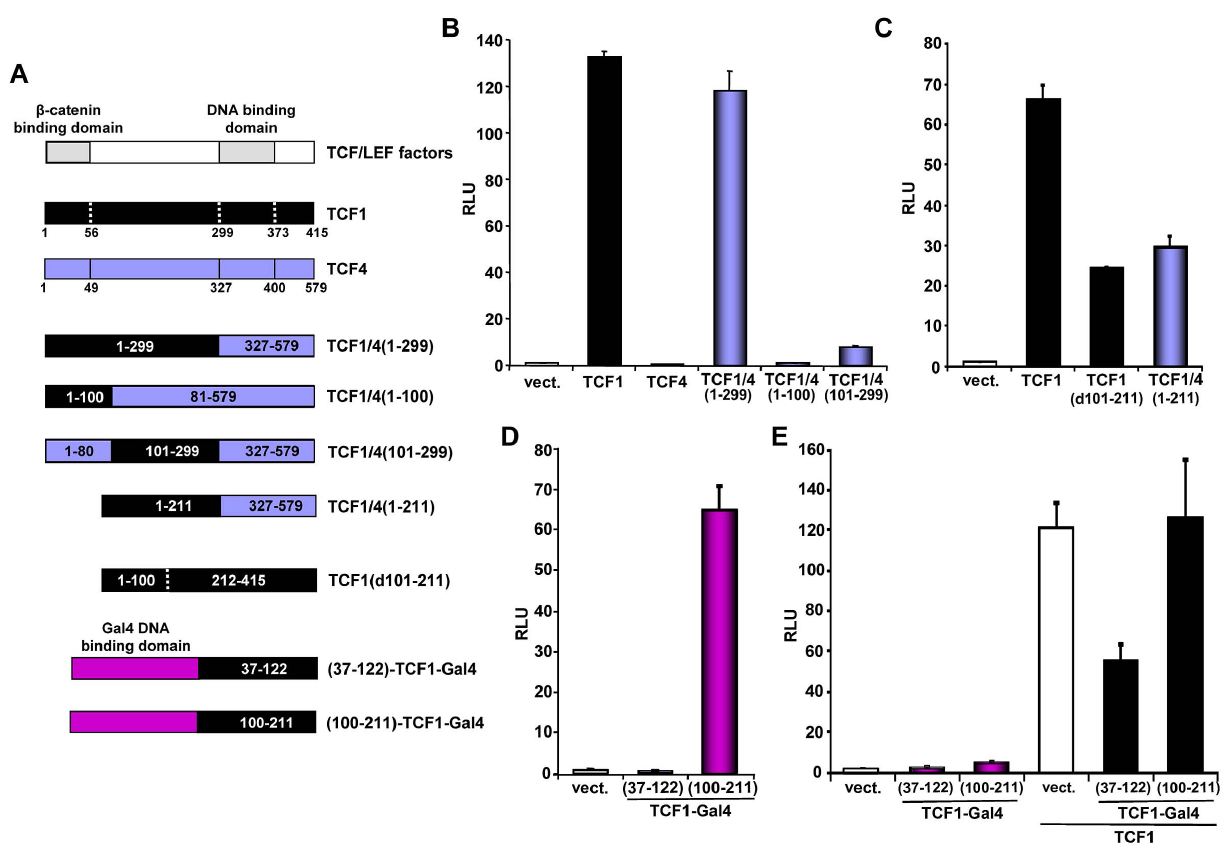
Figure 4. Mapping of the TCF1 domains involved in b -catenin-independent transcriptional activity. (A) Diagram of the different constructs used for the mapping. (B–D) 293T cells were co-transfected with the SuperTop reporter, the renilla plasmid and the indicated constructs, followed by reporter assay two days after transfection. (B) TCF1 N-terminal domain is required, but not sufficient, for b -catenin-independent full transcriptional activity. (C) Deletion of either aa 101–211 or 212–299 inhibits the b -catenin-independent transcriptional activity of TCF1. (D) Transcriptional activity of two different TCF1 domains fused to the Gal4 DNA binding domain. 293T cells were co-transfected with a Gal4 responsive reporter and the indicated TCF1-Gal4 fusion constructs, followed by reporter assay. (E) Expression of TCF1 aa 37–122, but not aa 100–211, inhibits TCF1-induced reporter activity. 293T cells were co-transfected with the Supertop reporter and the indicated TCF1-Gal4 fusion constructs, in the presence or the absence of TCF1, followed by reporter assay two days after